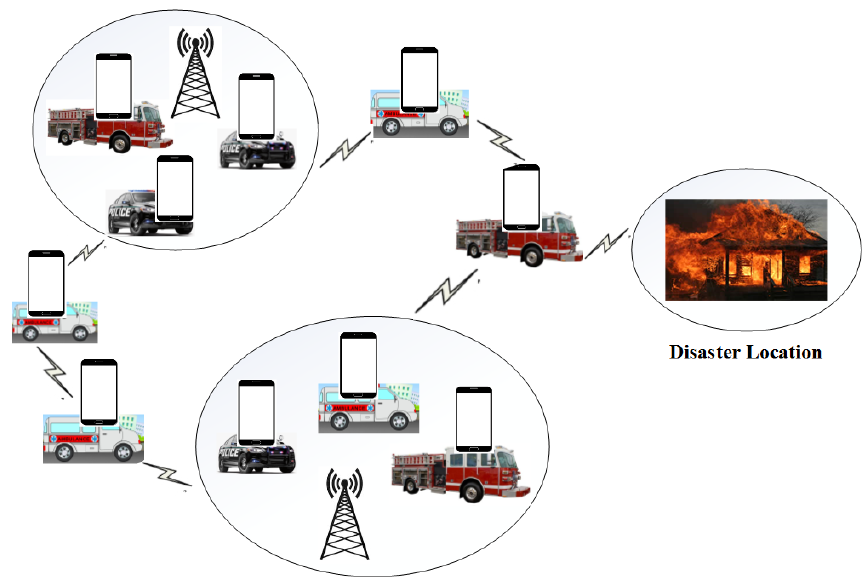
Figure 1. Opportunistic network for disaster recovery.